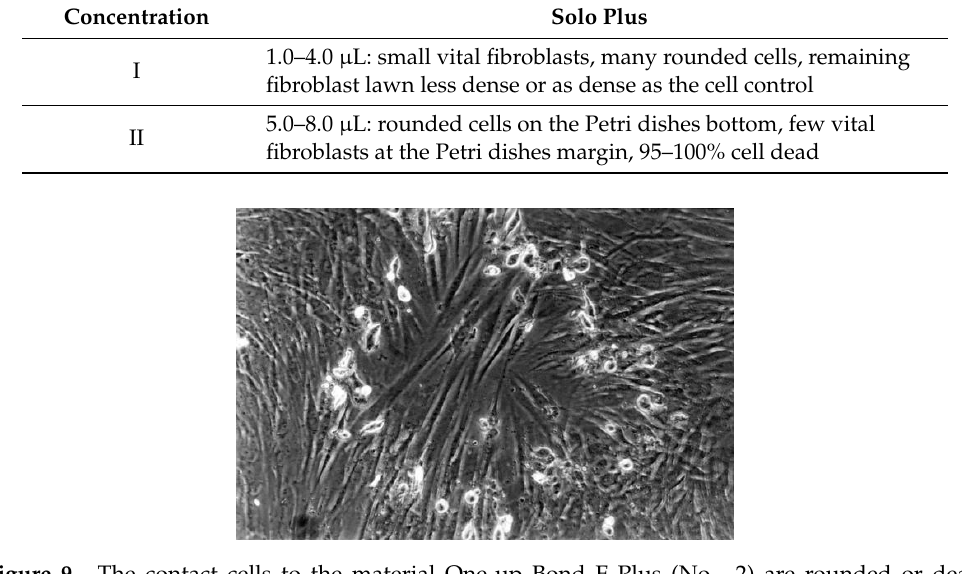
Figure 9. The contact cells to the material One-up Bond F Plus (No. 2) are rounded or dead. The fibroblast lawn is less dense than control cultures (100-fold magnification). Materials 2020 , 13 , x FOR PEER REVIEW